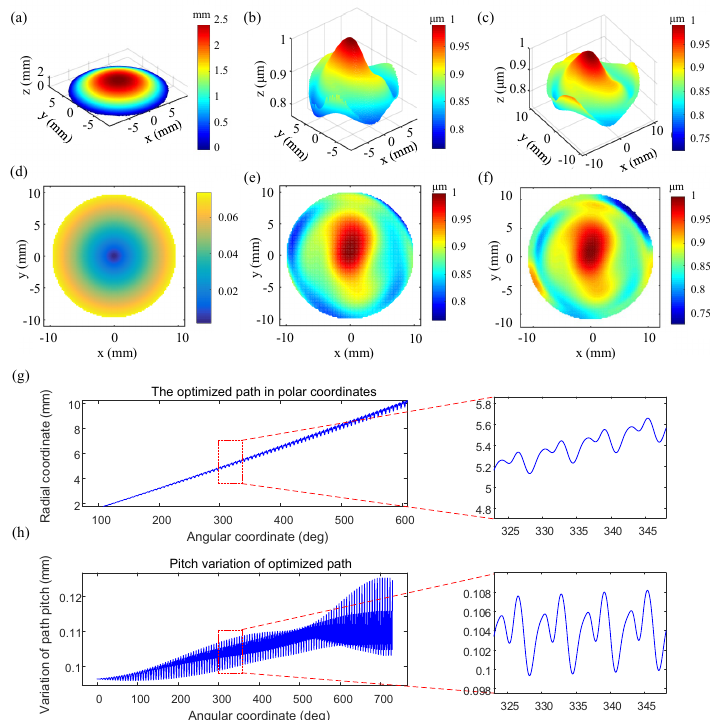
Figure 13. ( a ) Aspheric surface; ( b ) isometric view of the original form error distribution; ( c ) isometric view of the extended form error distribution; ( d ) slope distribution of the aspheric surface; ( e ) top view of the original form error distribution; ( f ) top view of the extended form error distribution; ( g ) RMS-map optimization path in polar coordinates; ( h ) variation of path pitches of the RMS-map optimization